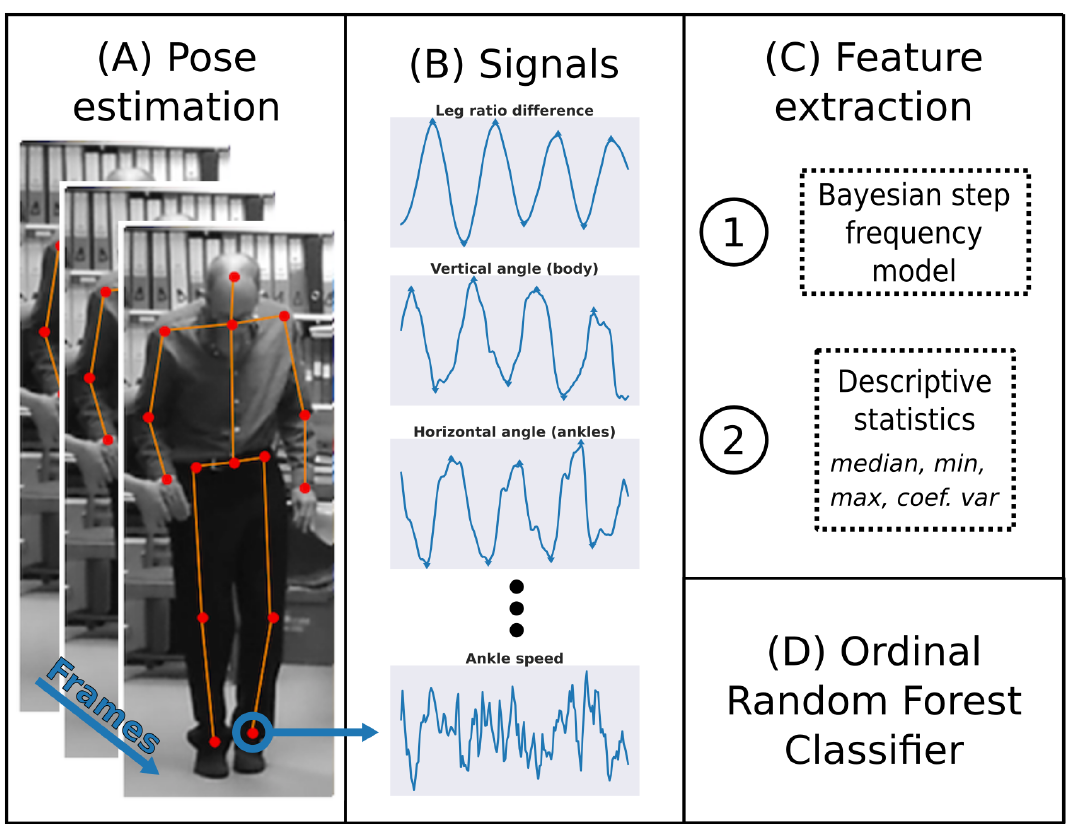
Figure 3. Methods overview. ( A ) Body key-points were extracted from each frame using the deep learning library OpenPose [17]. ( B ) Signals were created by combining the time-series of various key-points (see Section 2.3 and Table 1). ( C ) Features were extracted from the signals based on two different methods (Section 2.5): (1) a Bayesian step frequency model integrating information from three signals over time, and (2) summary statistics such as the median amplitude. ( D ) An ordinal random forest classifier was used to estimate patients’ UPDRS scores (see Section